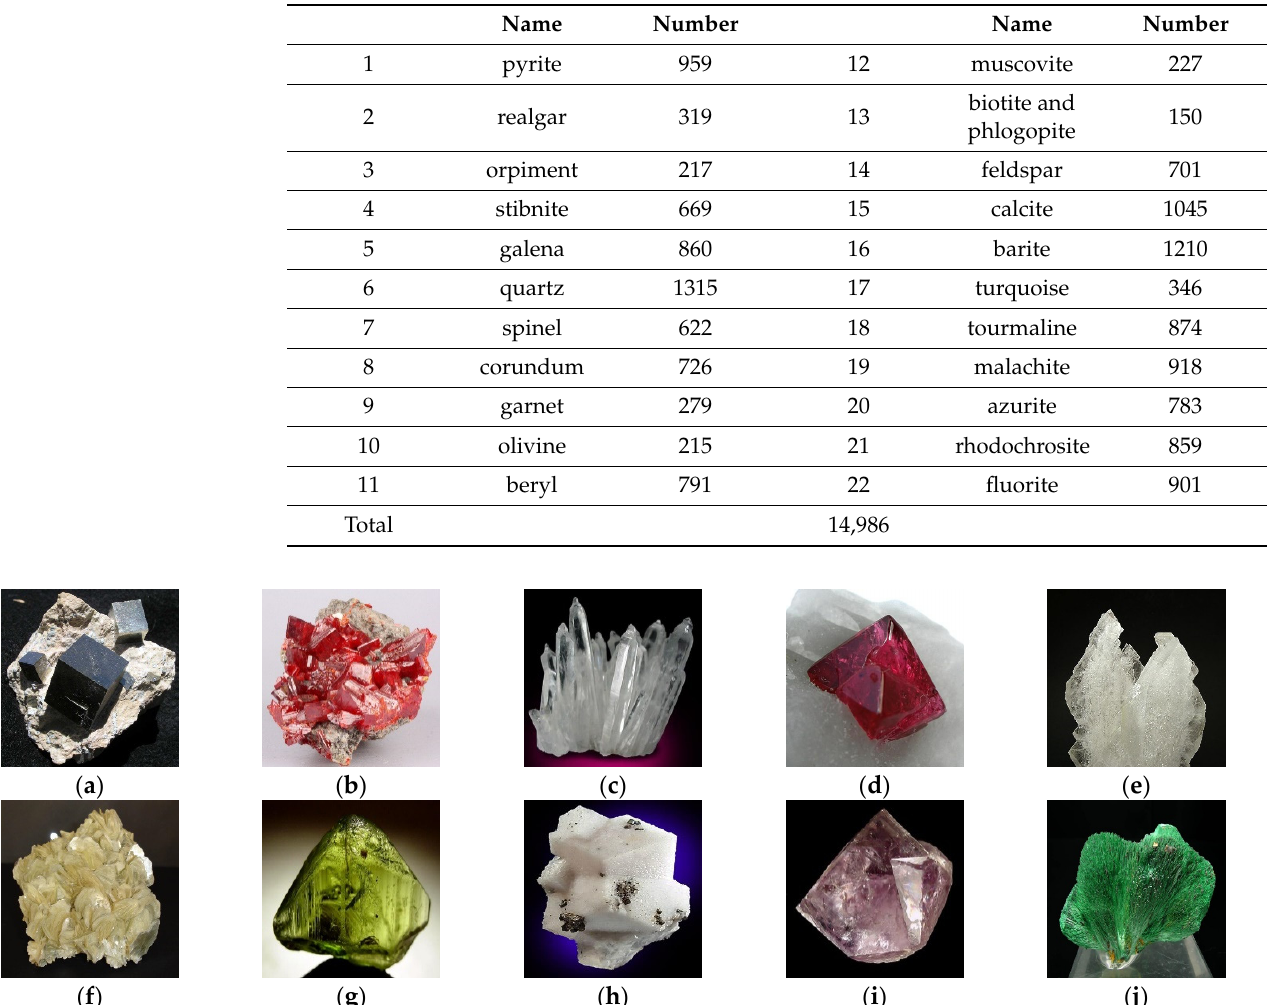
Figure 2. Mineral image samples. ( a ) Pyrite, ( b ) Realgar, ( c ) Quartz, ( d ) Spinel, ( e ) Barite, ( f ) Muscovite, ( g ) Olivine, ( h ) Calcite, ( i ) Fluorite, ( j ) Malachite. ( c , e – i ) are single minerals, ( a ) and ( b ) contain surrounding rocks, ( d ) contains symbiotic minerals, and ( j ) includes a base.